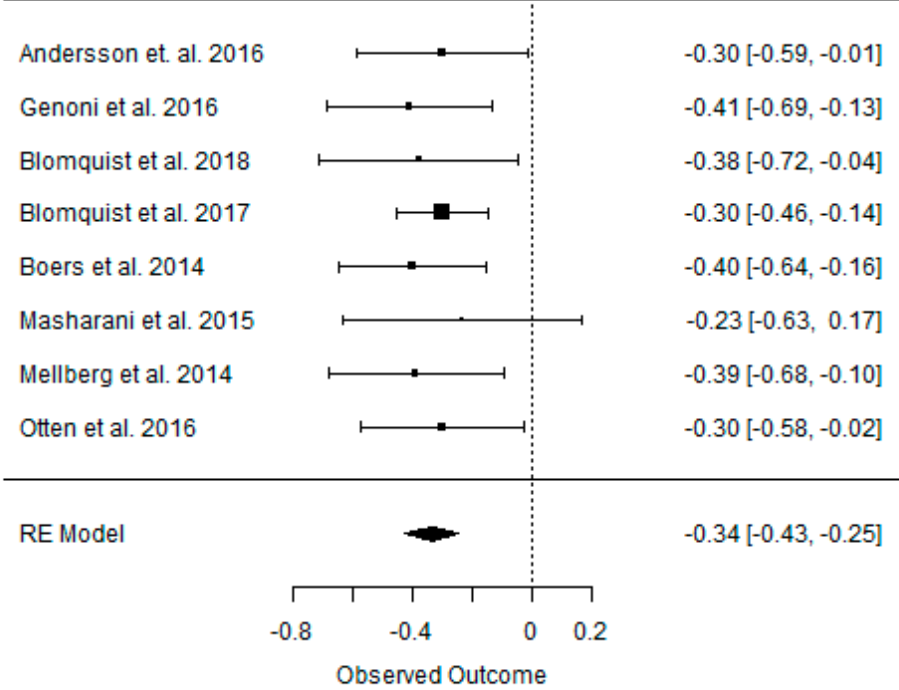
Figure A16. Forest plot of the effect of a CD on TC in the short term (weighted mean difference).